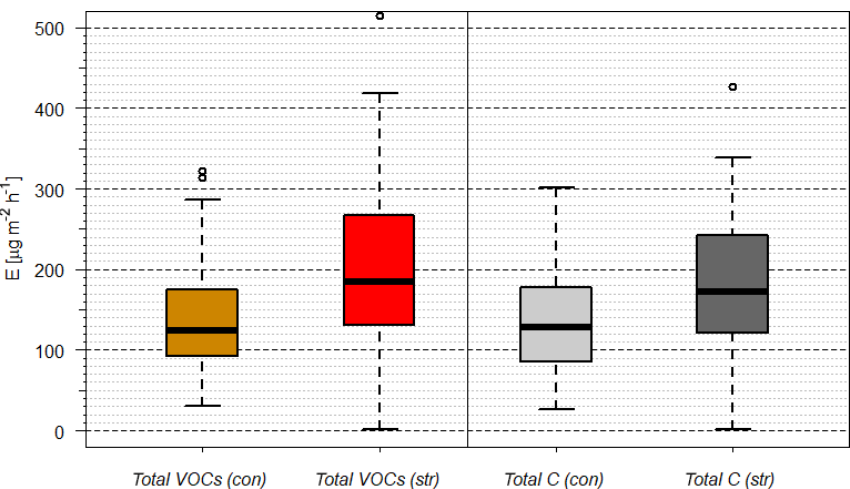
Figure 5. Change for the total sum of VOCs (left) and total carbon (right) emission fluxes of Fagus sylvatica for two SM conditions (Rombach, 2018). Because of the abnormally distributed data, values are stated as the median, 25th percentile (lower) and 75th (upper) percentile.